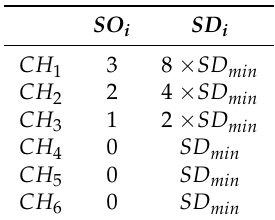
Table 1. Superframe Durations for all